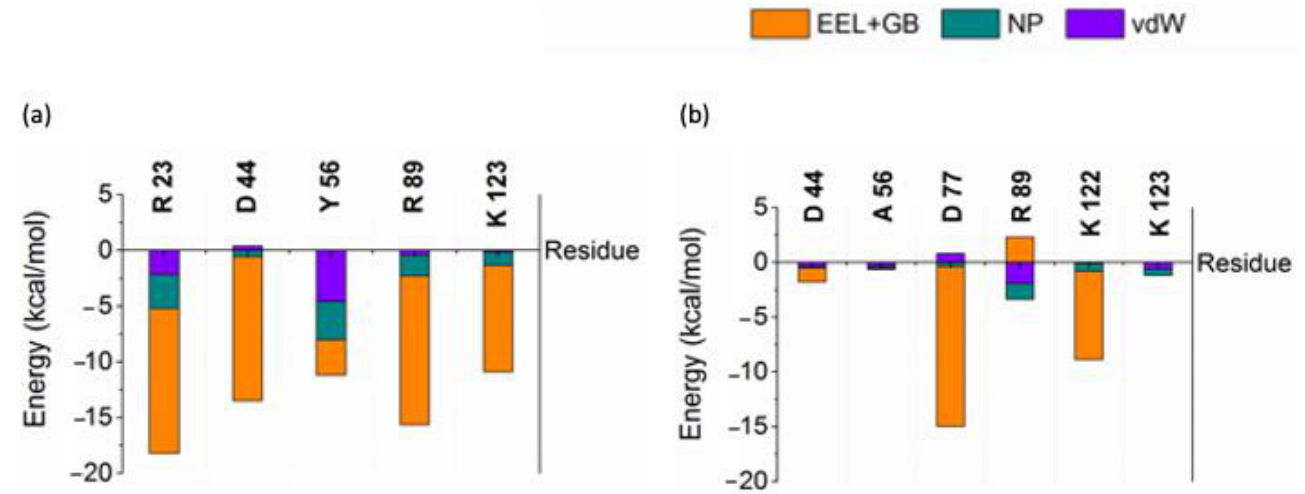
Figure 1. Interaction free energy of key residues ( a ) Ank GAG 1D4 and ( b ) Ank GAG 1D4-Y56A in complex.